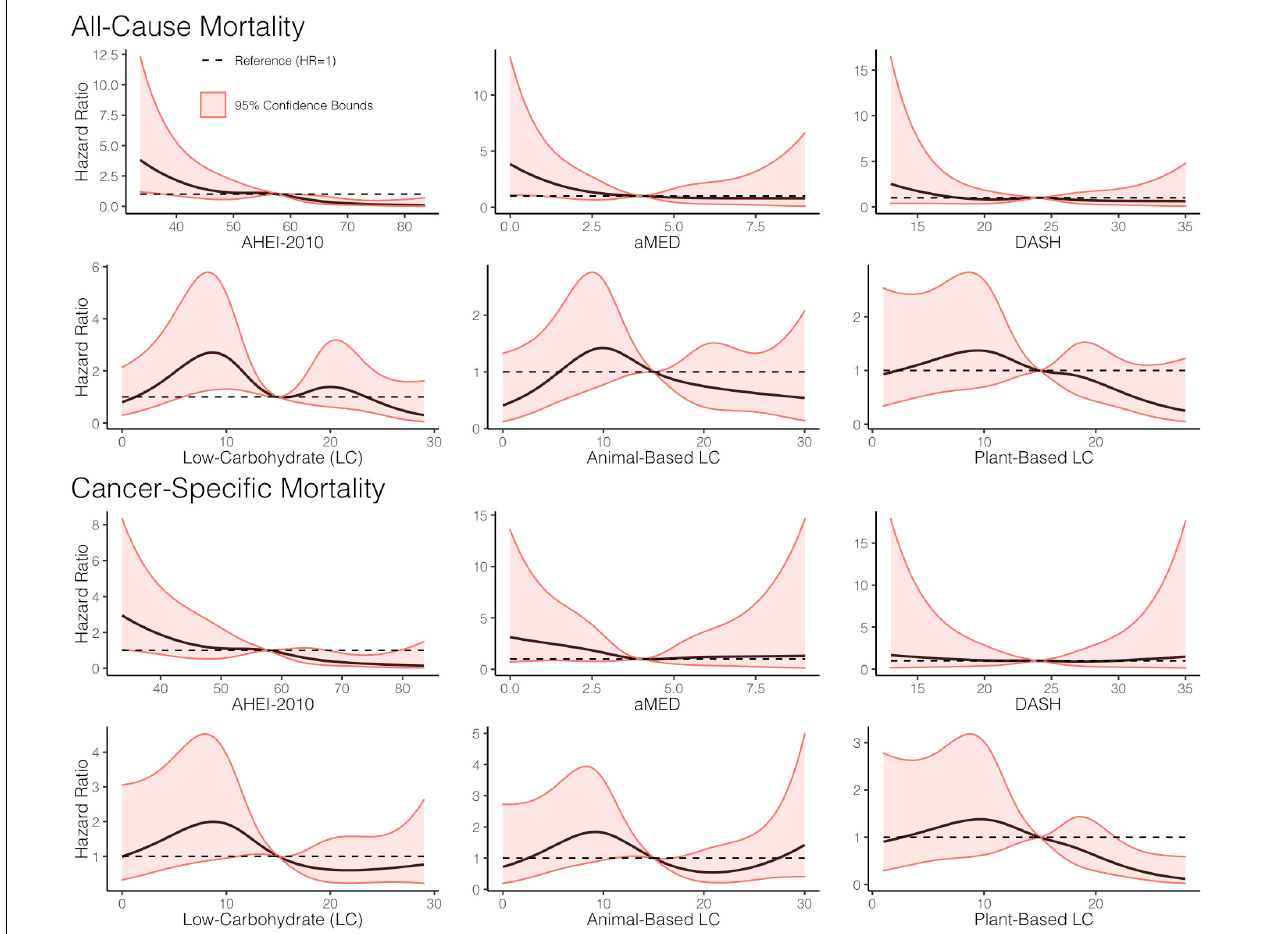
FIGURE 3 | Dose-response relationship between adherence to a priori diet quality indices, all-cause, and cancer-specific mortality. Restricted cubic splines, with five knots, were used to construct smooth curves from models that evaluated the indices as continuous variables and were weighted using the weights from the marginal structural models. Hazard ratios (HR) were computed with the referent set as the hazard for the median index score. A dashed line showing HR = 1 is included for reference. All models adjusted for baseline age, sex, tumor site, stage, human papillomavirus (HPV) status, treatment modality, ACE-27, the highest level of education attained, index score measured at the previous encounter, smoking status, caloric intake, and body mass index